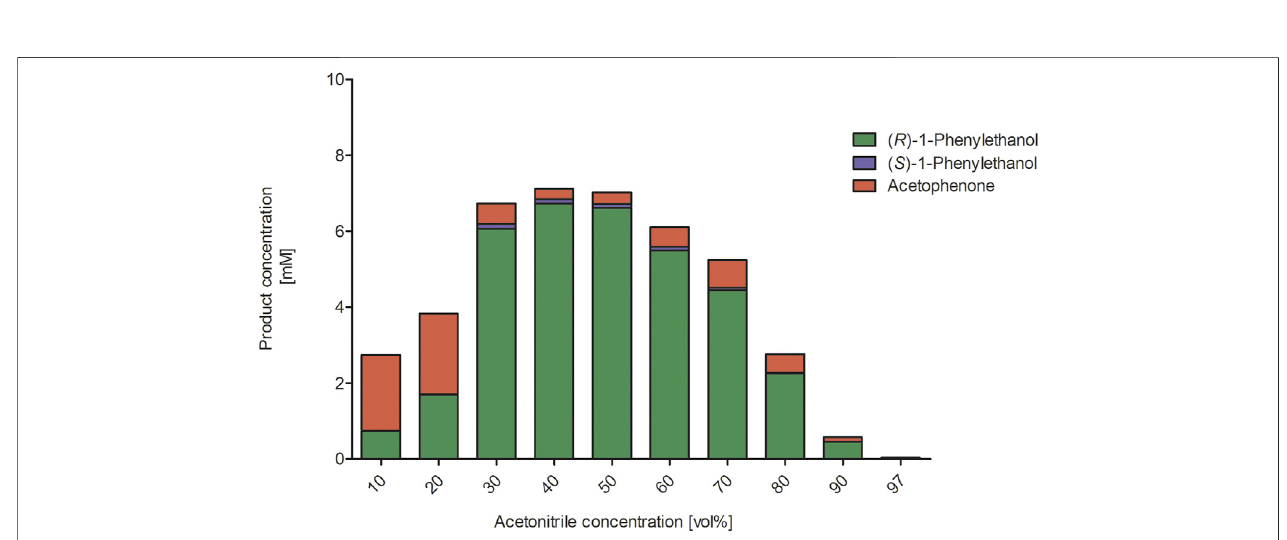
FIGURE 3 | In fl uence of increasing acetonitrile concentrations on r Aae UPO-catalyzed hydroxylation of ethylbenzene. Reaction conditions: The reactions were performed in technical duplicates in potassium phosphate buffer (0.5 mL, 100 mM, pH 6.0) at 25 ° C and 600 min − 1 for 2.5 h. Reaction mixtures contained substrate (10 mM in 10 – 97 vol% ACN), r Aae UPO (1 μ M, concentrated supernatant) and up to 10 mM H 2 O 2 , which was added in 2 mM portions every hour. The concentration of the analytes derived from calibration curves. GC-analysis on the chiral column (CP-Chirasil-Dex